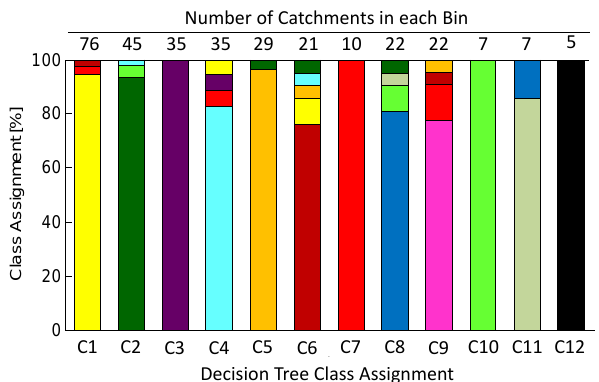
Fig. 4. Analysis of CART analysis results with respect to the per- centage of classes that have been assigned (correct assignment: min is 76%; avg. is 91%). Colors are used to show misclassification through